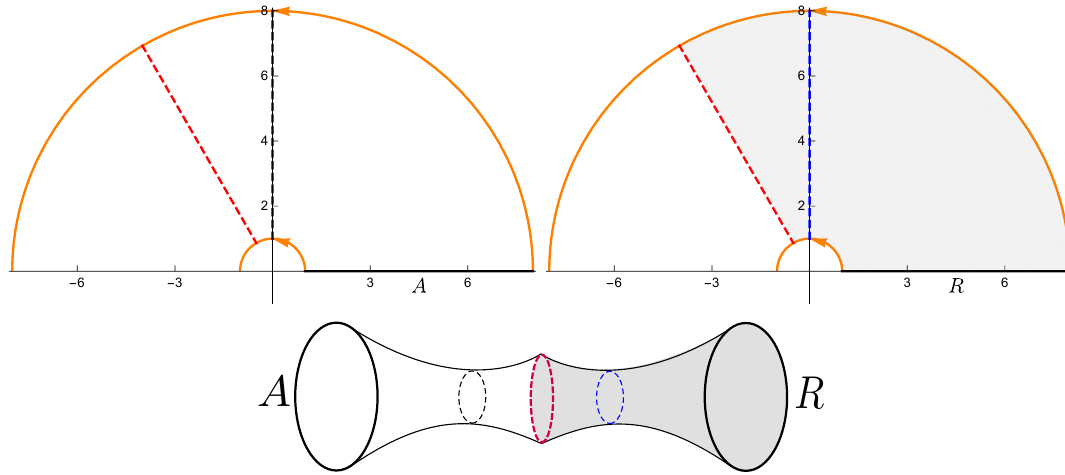
Figure 11 . Top left: a covering space depiction of the \real" region, (cid:12)gure 1b, the surface (cid:6) 2 after introducing an EOW brane. The dashed red segment is the EOW brane, which cuts o(cid:11) one asymptotic region (region B from (cid:12)gure 10). The region bounded by the black line (asymptotic boundary A ), orange lines, and dashed red line forms a fundamental region for the geometry. Top right: the geometrization of the brane CFT into the inception region (gray), another cut o(cid:11) copy of (cid:6) 2 . The length of the brane in the inception region must match its length in the real region (top left). The dashed red segments on the top left and top right are identi(cid:12)ed, causing the real region to form a long wormhole into the inception region, stretching from the real asymptotic region A to the radiation asymptotic region R . The dashed blue line is the horizon of the inception black hole. Bottom: the glued